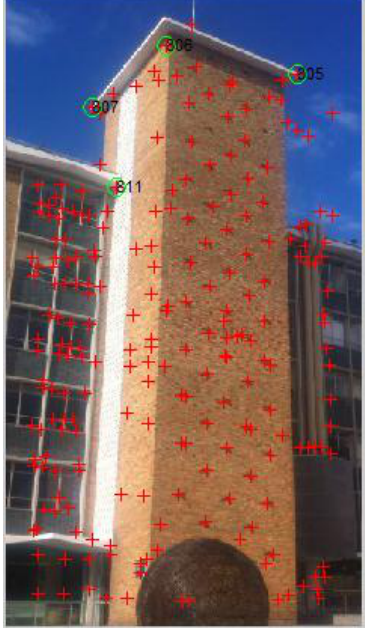
Figure 1. Reference image No. 15: Corner points have been extracted by Harris corner detector and shown with red crosses; 4 geo-located corner points have been identified and shown in green